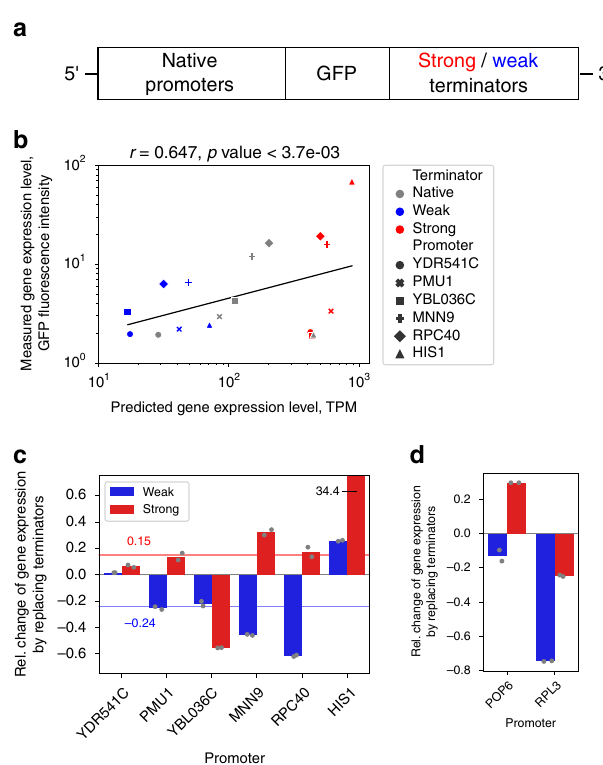
Fig. 6 Experimental analysis demonstrates the potential of using the models to fi ne-tune gene expression. a Conceptual diagram of experiment and constructs. b Correlation analysis between model predictions and measured GFP fl uorescence levels for constructs with 6 promoters in combination with native (grey) as well as strong (red) and weak (blue) terminators ( n = 18). Black line denotes least squares fi t. c Relative change in measured GFP fl uorescence levels of the constructs, where native terminators were replaced with either strong (red bars) or weak (blue bars) variants with n = 2 technical replicates indicated as grey points (see text and Supplementary Table 13). On average, the GFP fl uorescence levels shifted by 20% in the directions of the predicted levels. Red and blue lines denote median values with strong and weak promoters, respectively. d Additional tests with the weak POP6 and strong RPL3 promoters, whose CDS were more dissimilar to GFP. Native terminators were replaced with either strong (red bars) or weak (blue bars) variants with n = 2 technical replicates indicated as grey points. Source data are provided as a Source data fi